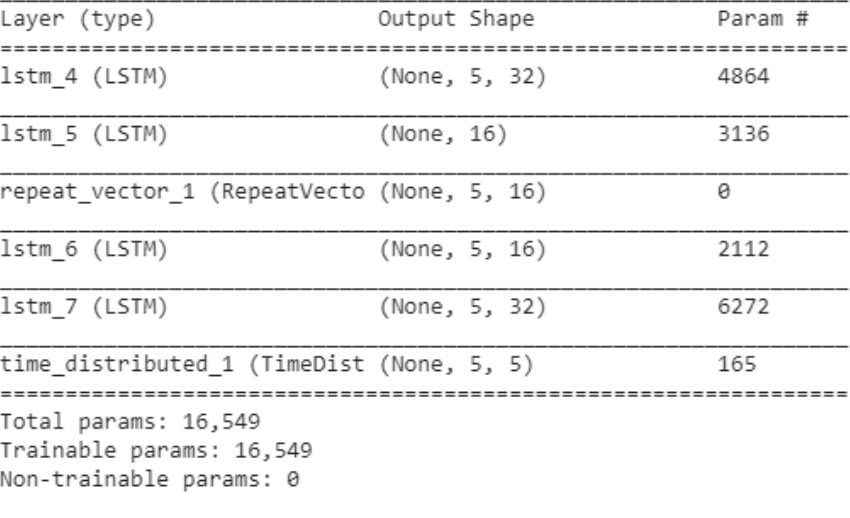
Figure 23. The details about RoMADS model during the training.